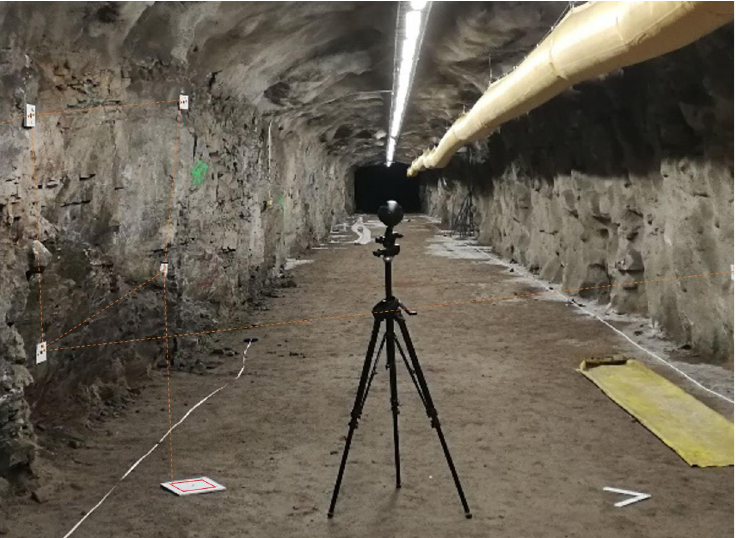
Figure 1. Photo depicting part of the tunnel section that was selected for testing the 360-degree camera for photogrammetric digitization and remote rock mass mapping. Control distances were measured between the control points mounted on the tunnel wall (example illustrated with an orange dashed line). An orientation board with four control points was placed on the floor (white board in the lower left corner) and was used to orient the model.